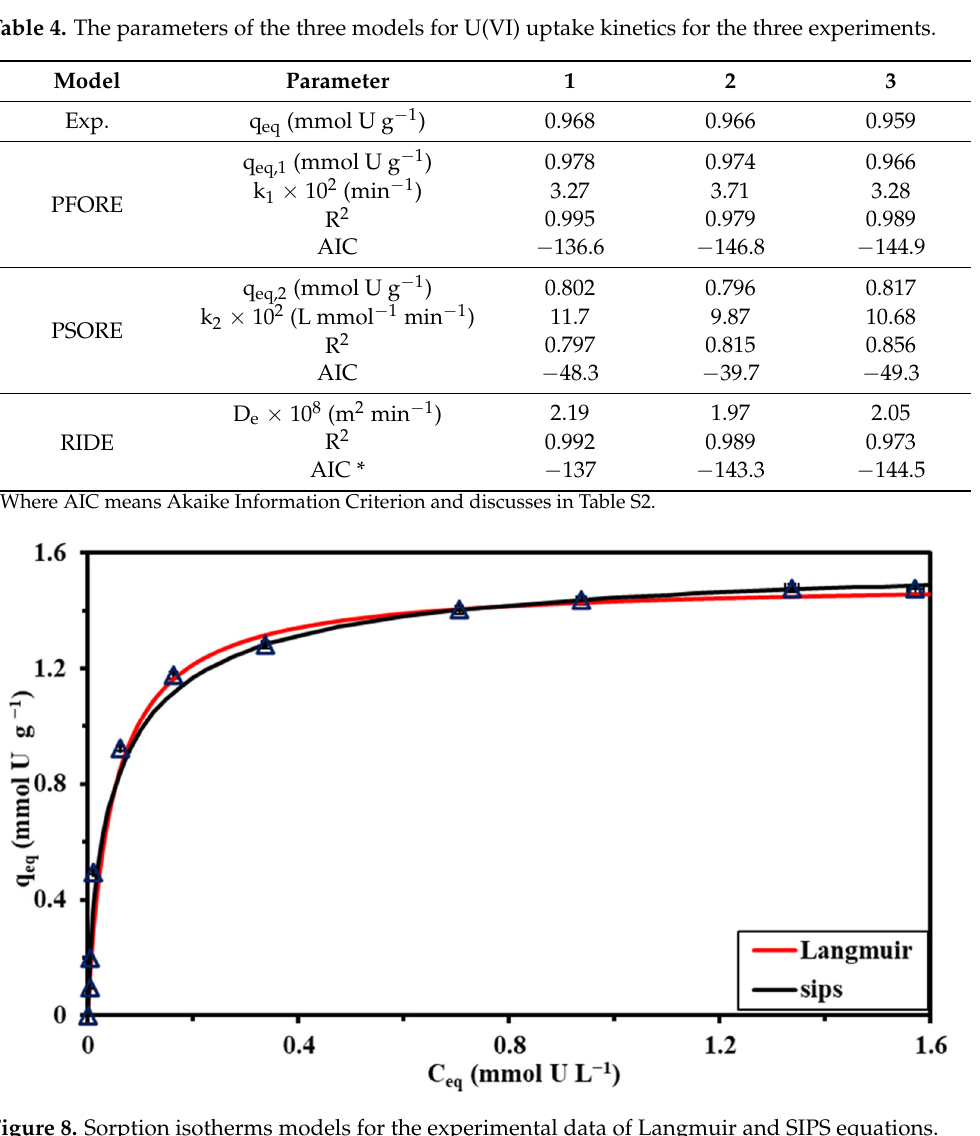
Figure 8. Sorption isotherms models for the experimental data of Langmuir and SIPS equations.